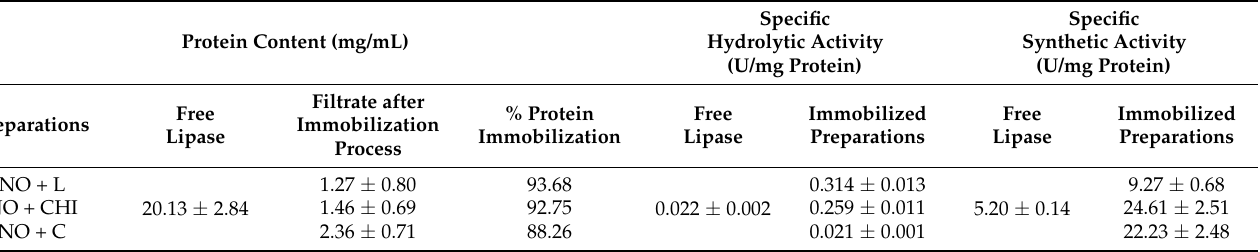
Table 1. The protein content, specific hydrolytic activity, and specific synthetic activity of various free and immobilized lipases: NO + L: liquid lipase Novozym 51032 immobilized on Lewatit VP OC 1600; NO + C: liquid lipase Novozym 51032 immobilized on coffee grounds; NO + CHI: liquid lipase Novozym 51032 immobilized on chitosan powder. Specific Protein Content (mg/mL) Hydrolytic Activity (U/mg